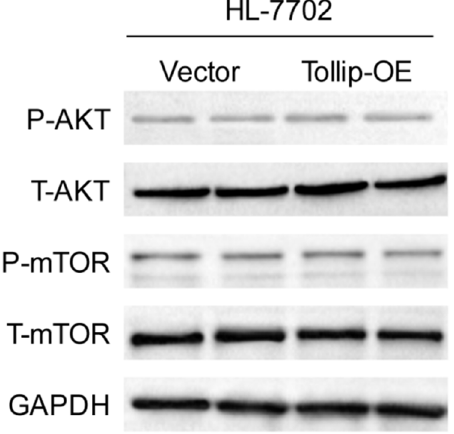
Figure A1: The regulation of PI3K/AKT signaling pathway in HL - 702 cells by Tollip. Immunoblot showed AKT and mTOR phosphorylation and total levels in HL - 7702 infected with Tollip - OE and vector group. n = 3 independent experiments. * p < 0.05 compared with control